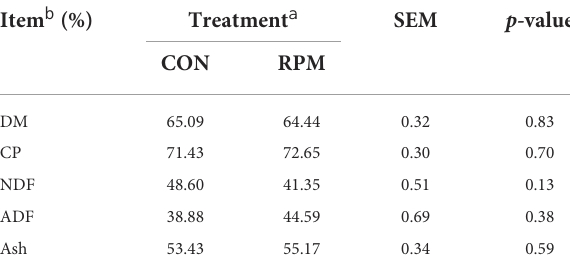
TABLE 4 Effects of supplementing with rumen-protected methionine (RPM) on the apparent digestibility of